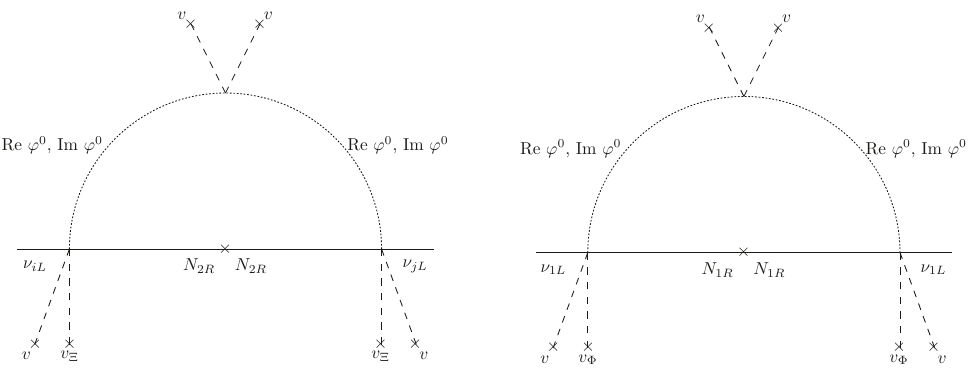
Figure 1 . Loop Feynman diagrams contributing to the entries of the neutrino mass matrix. Here i; j = 1 ; 2 ; 3. The cross marks in the internal lines with N nR of the mass m N nR